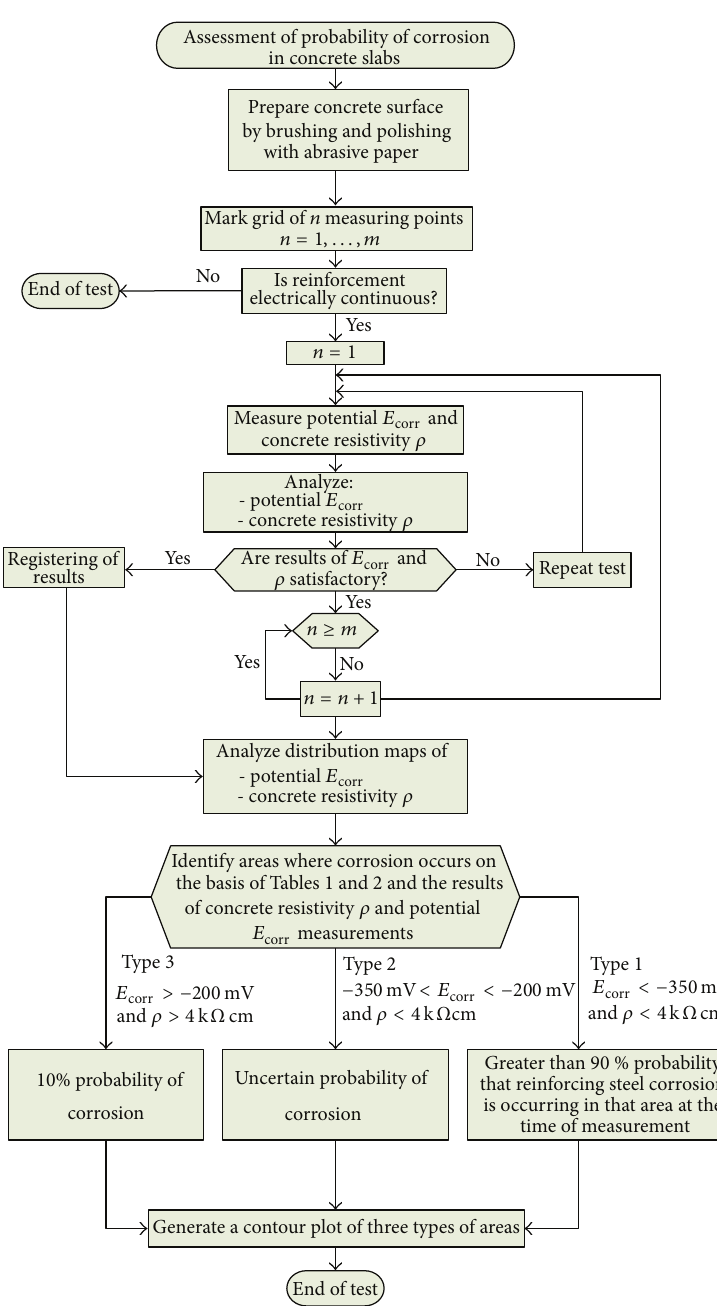
Figure 2: Assessment of probability of corrosion in concrete slabs through half-cell potential and concrete resistivity measurements.